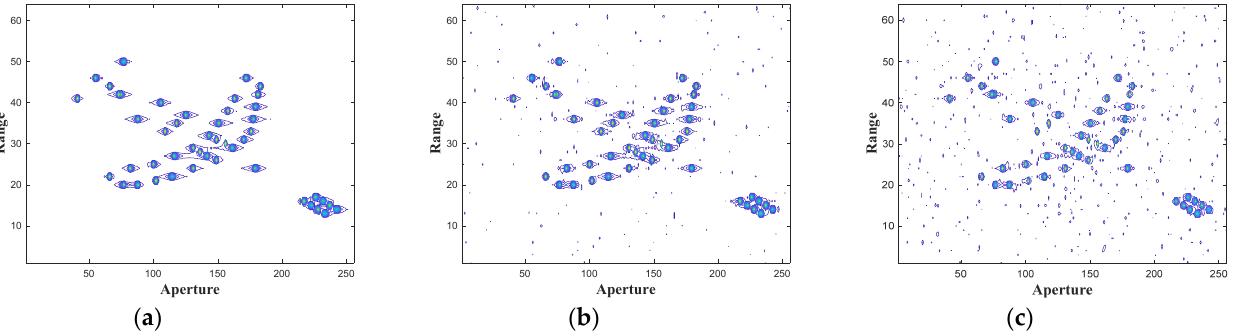
Figure 9. The recovered image applied the Burg method under different SNR levels. ( a ) 20 dB. ( b ) 10 dB. ( c ) 5 dB.